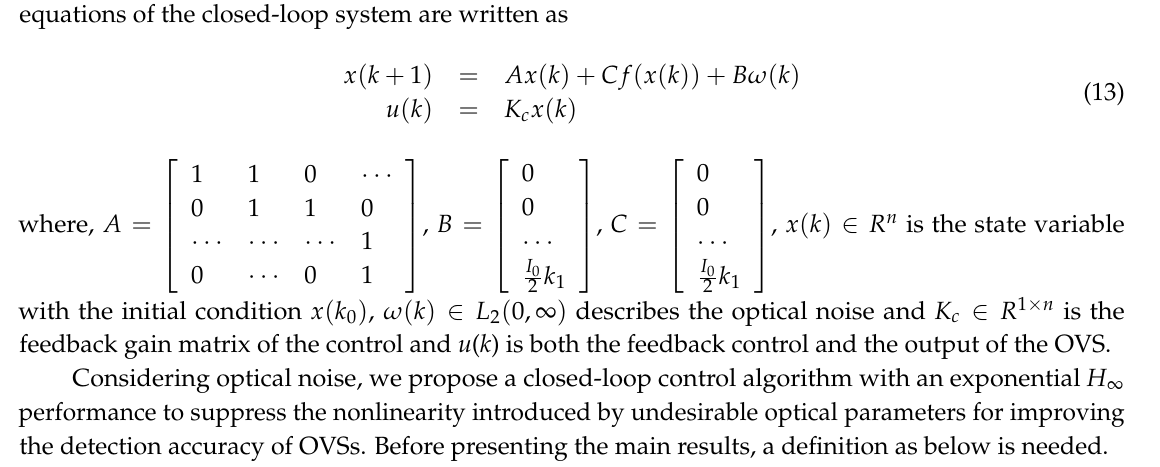
Figure 6. The influence of ν and θ on the measurement accuracy of closed-loop OVS.